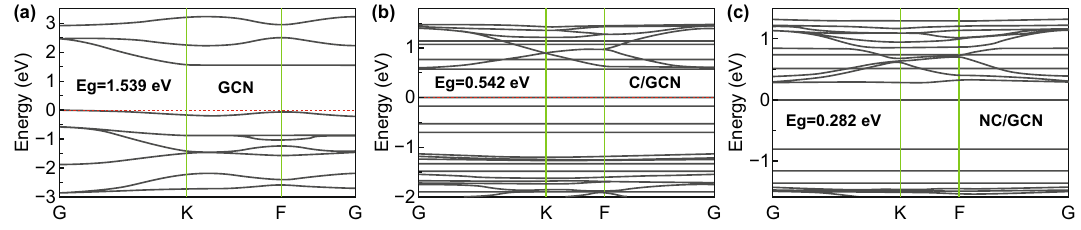
Fig. 7 a The band structures of pristine GCN, b C/GCN, and c NC/GCN systems; the red dash line at energy 0 is the position of Fermi level